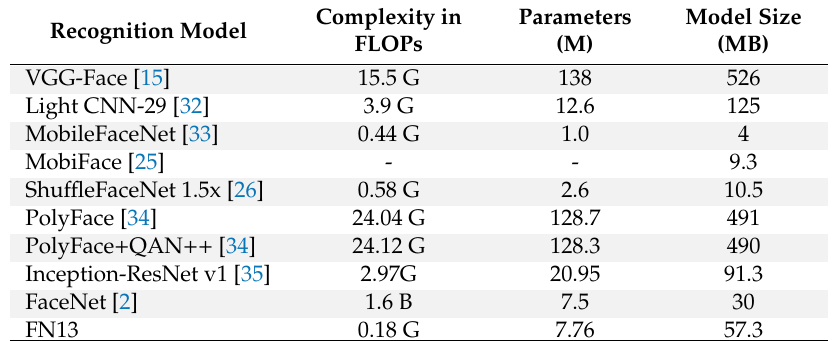
Table 3. The performance comparison between the proposed FN13 and other typical CNN models.